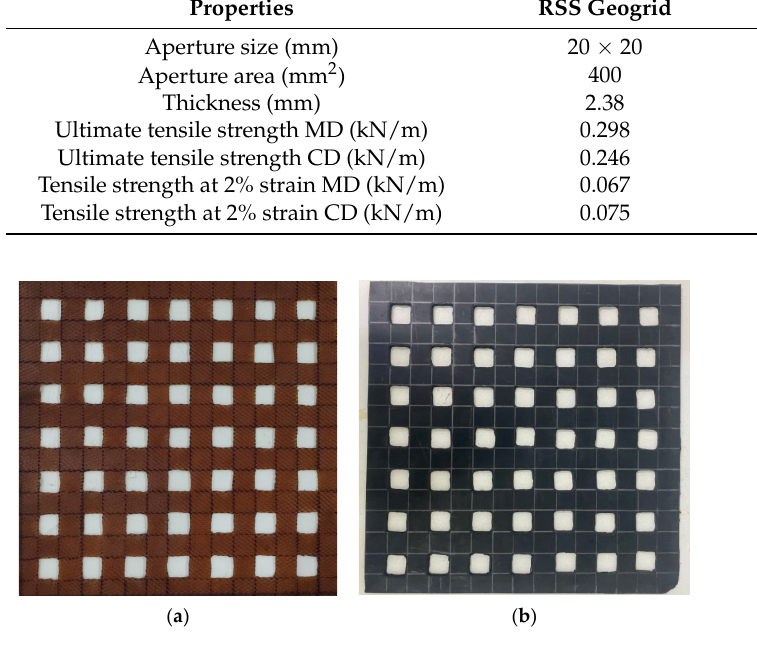
Figure 4. ( a ) RSS geogrid; ( b ) RCS geogrid. Table 2. Engineering properties of reinforcement material.